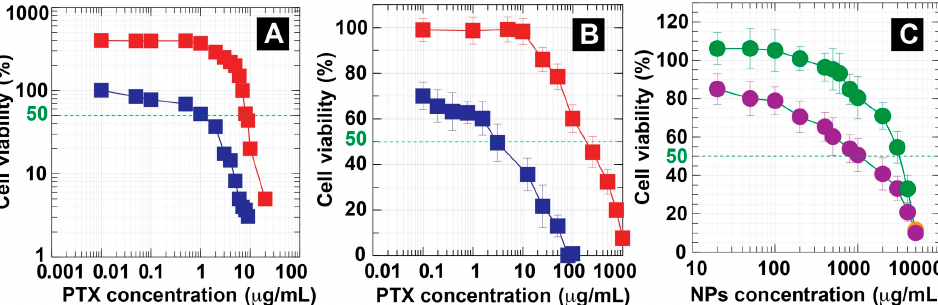
Figure 8. Cellular viabilities of ( A ) breast cancer cells and ( B ) fibroblast cells after treatment with free PTX ( ) and PTX-loaded DC-WCS-PG NPs ( ). ( C ) Cellular viabilities of MCF-7 breast cancer cell lines ( ) and the CRL 2522 fibroblast cell line ( ) after treatment with the blank DC-WCS-PG NPs.